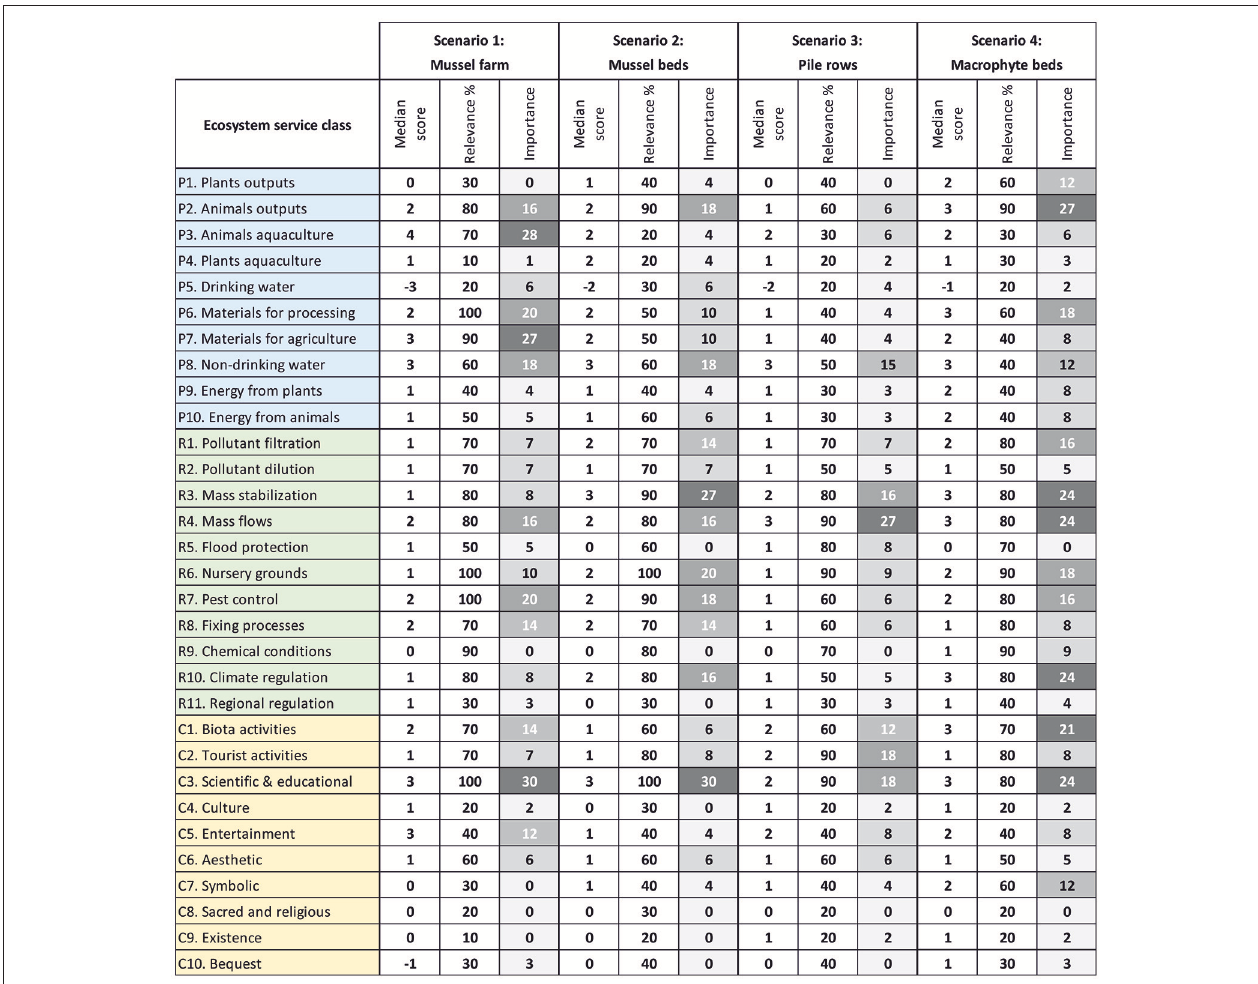
FIGURE 7 | Median scores for each ecosystem service, their relevance (% of evaluators that considered the service as relevant for this scenario) and the resulting importance (score*importance/10).